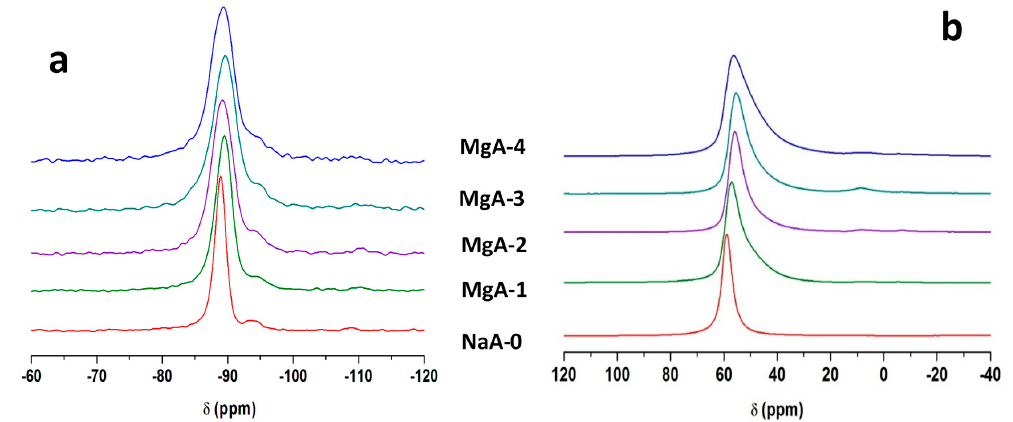
Figure 5. 29 Si-MAS NMR spectra ( a ) and 27 Al-MAS NMR spectra ( b ) of NaA-0 and its associated MgA-1 to MgA-4 samples. Only the isotropic region is shown.